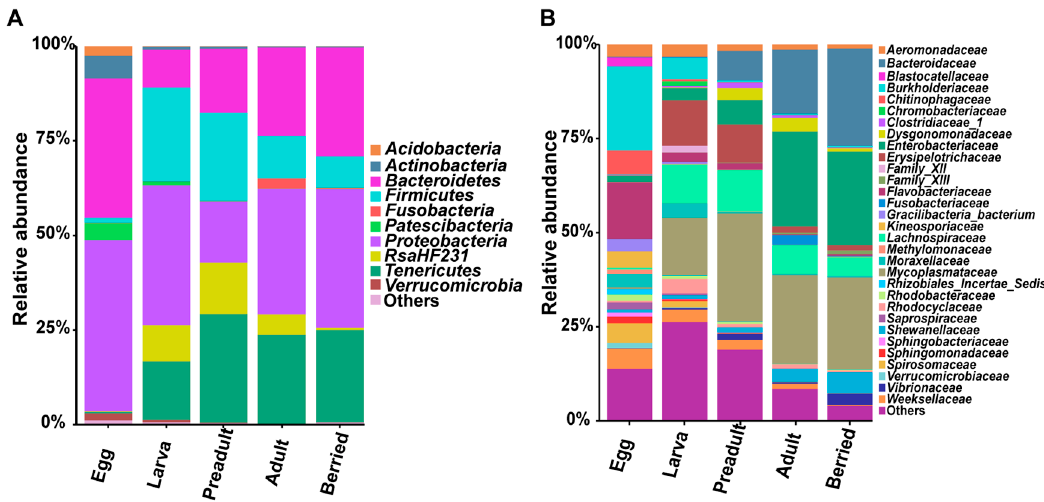
Figure 5. Dominant bacteria at different developmental stages. ( A ) Relative abundances of the dominant bacteria at the phyla level. ( B ) Relative abundances of the dominant bacteria at the family level.